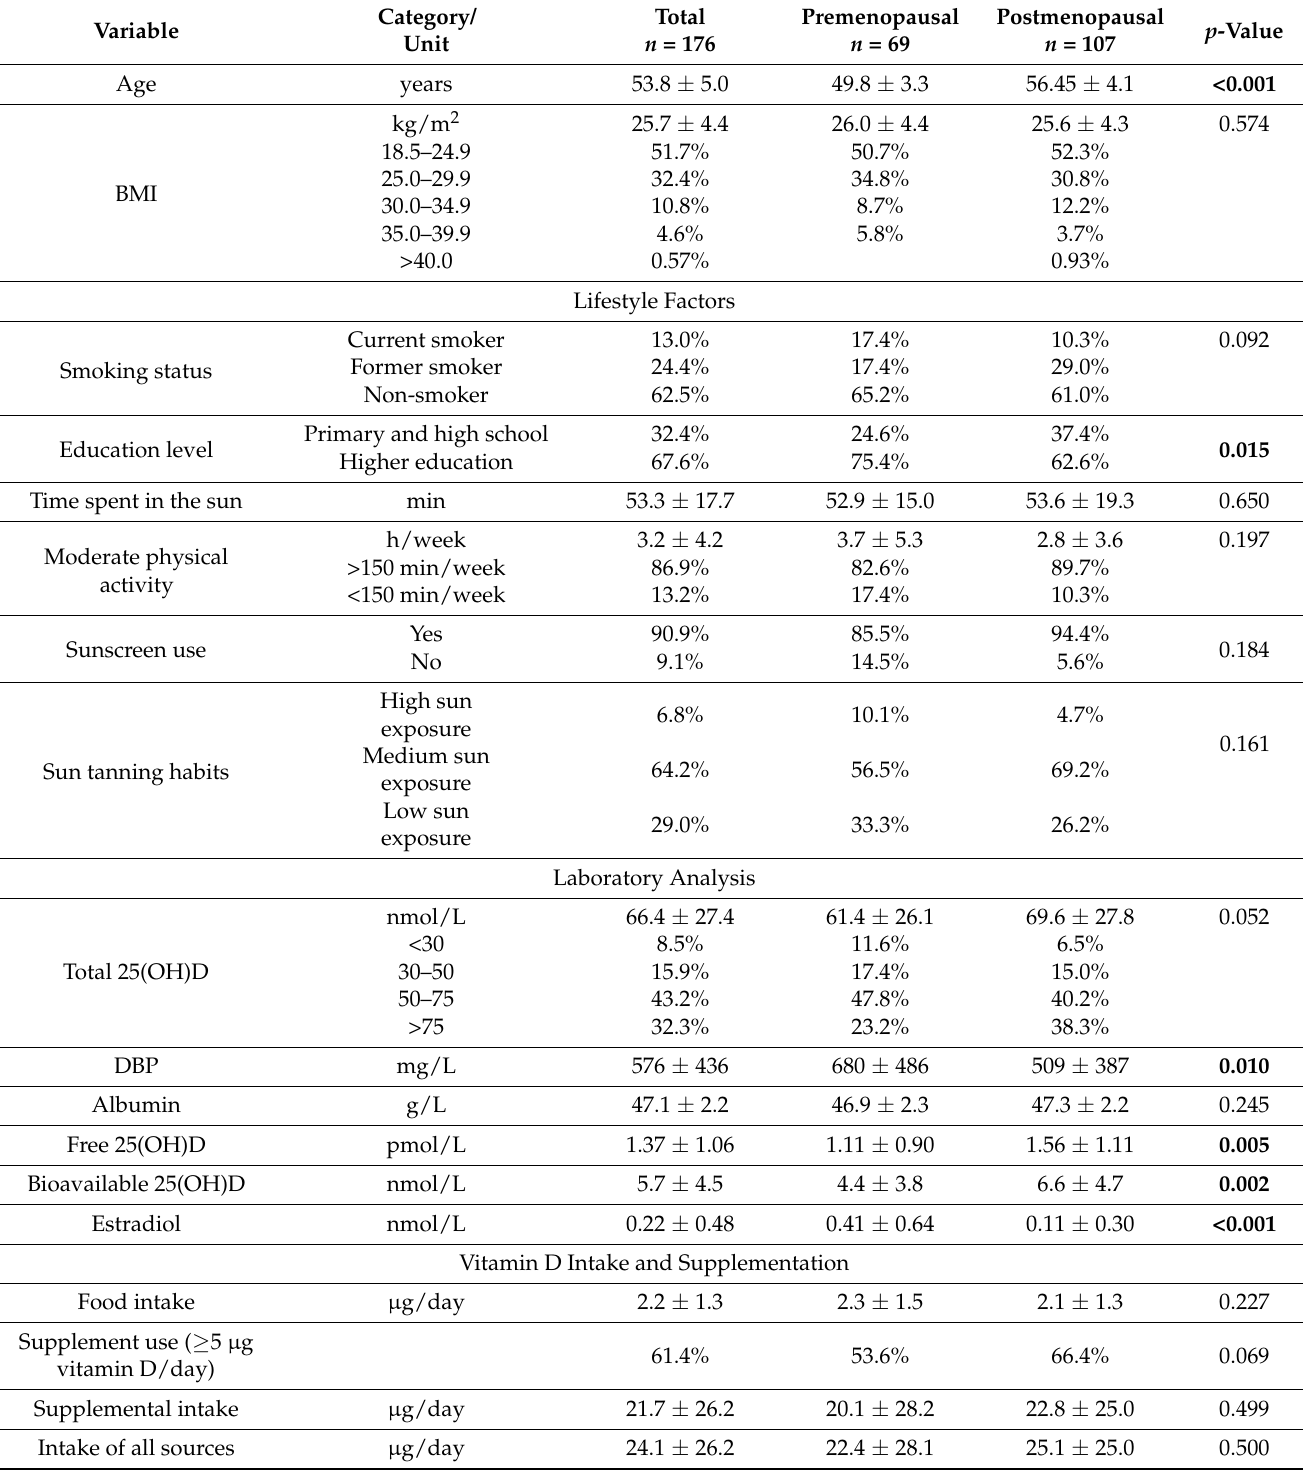
Table 1. Population characteristics, vitamin D status, supplementation, and food intake of healthy women, aged between 44 and 65, from the Central Slovenian region, who were included in the study carried out between 1 March 2021 and 31 May 2021 ( n =